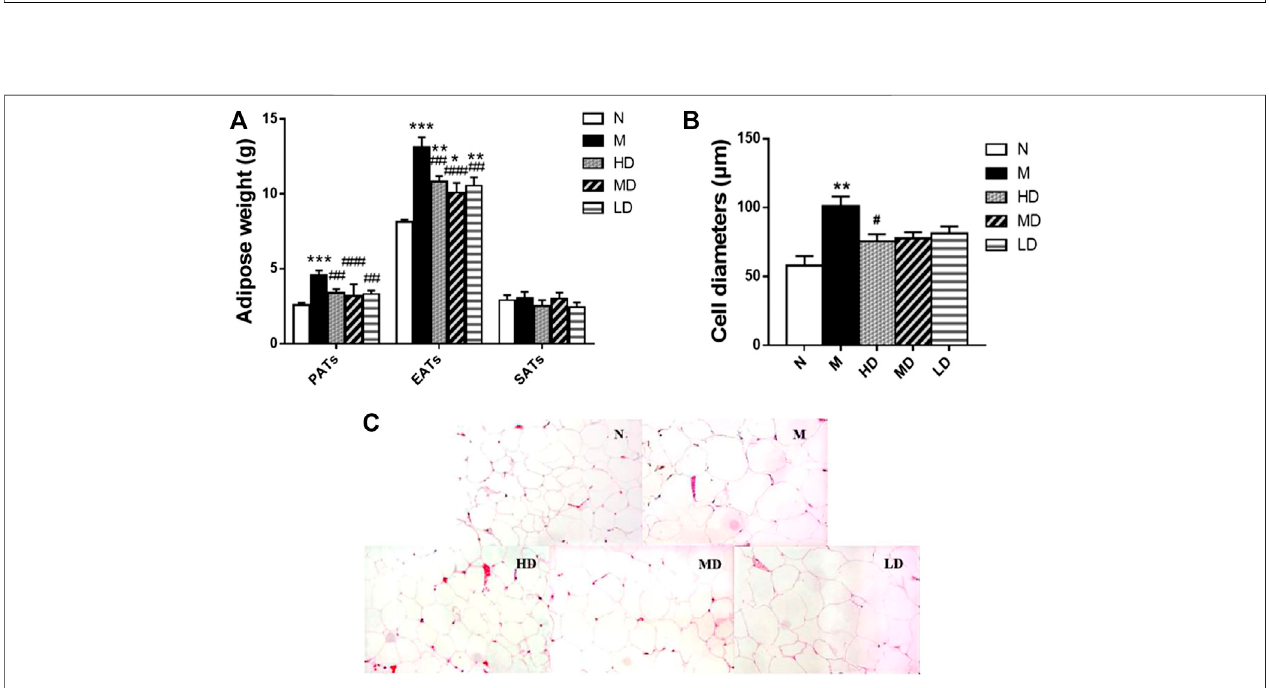
FIGURE 3 | Effect of CQR on the morphology and cell diameters of adipocytes in obese rats. (A) The weight of perinephric adipose tissues (PATs), epididymal adipose tissues (EATs) and subcutaneous adipose tissues (SATs); (B) diameters ofepididymal adipocyte; (C) epididymal adipocyte size. Data are expressed asmean ± SEM ( n (cid:1) 10). * p < 0.05, ** p < 0.01, *** p < 0.001, vs. N group; # p < 0.05, ## p < 0.01, ### p < 0.001, vs. M group.